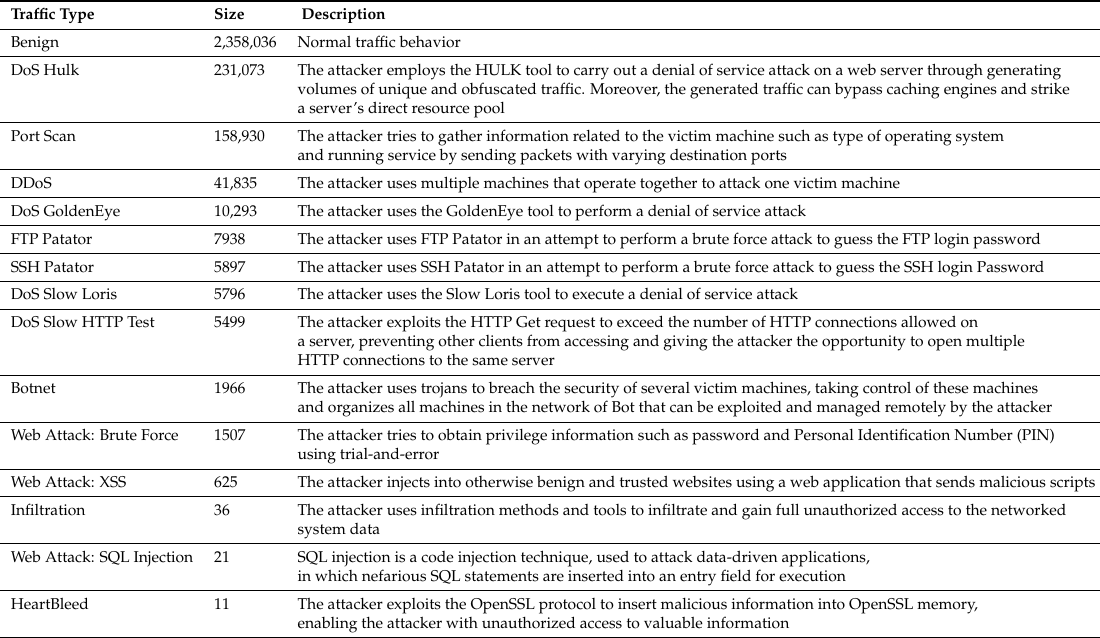
Table 2. CICIDS2017 attack distribution and